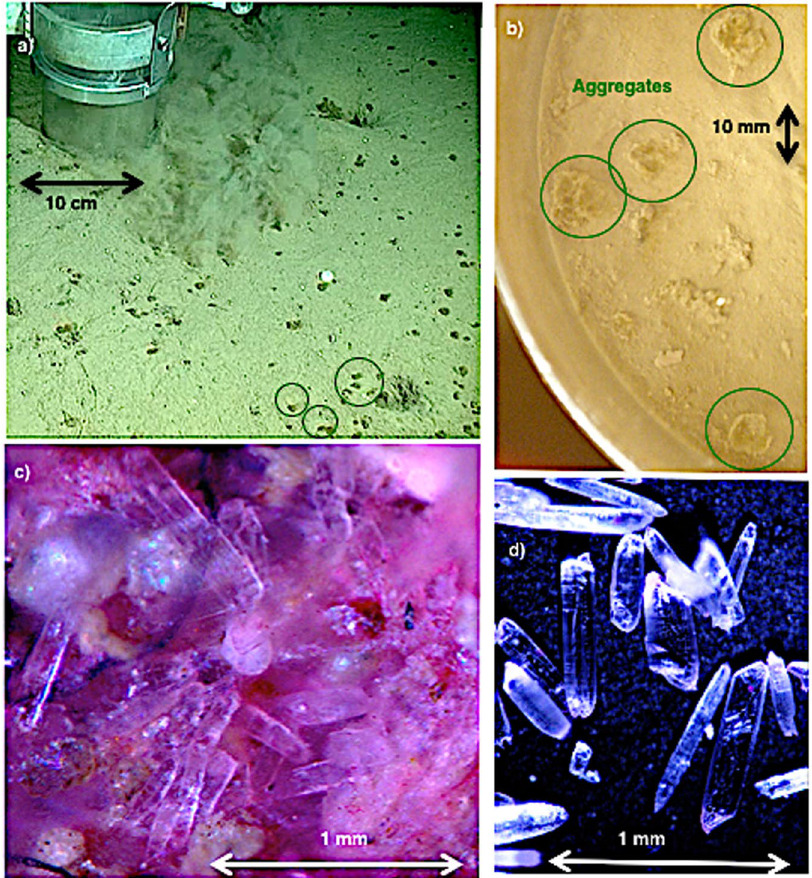
Figure 2. Images of Phaeocystis aggregates and associated gypsum crystals. ( a ) Phaeocystis aggregates (examples indicated by green circles) observed on the sea floor at 2146 m depth. ( b ) Phaeocystis aggregates (green circles) from the top of a multicorer tube surface. ( c ) Gypsum crystals entangled in Phaeocystis colonial strands. Remains of Phaeocystis aggregates are stained pinkish by the protein stain Rose Bengal 18 . ( d ) Isolated gypsum